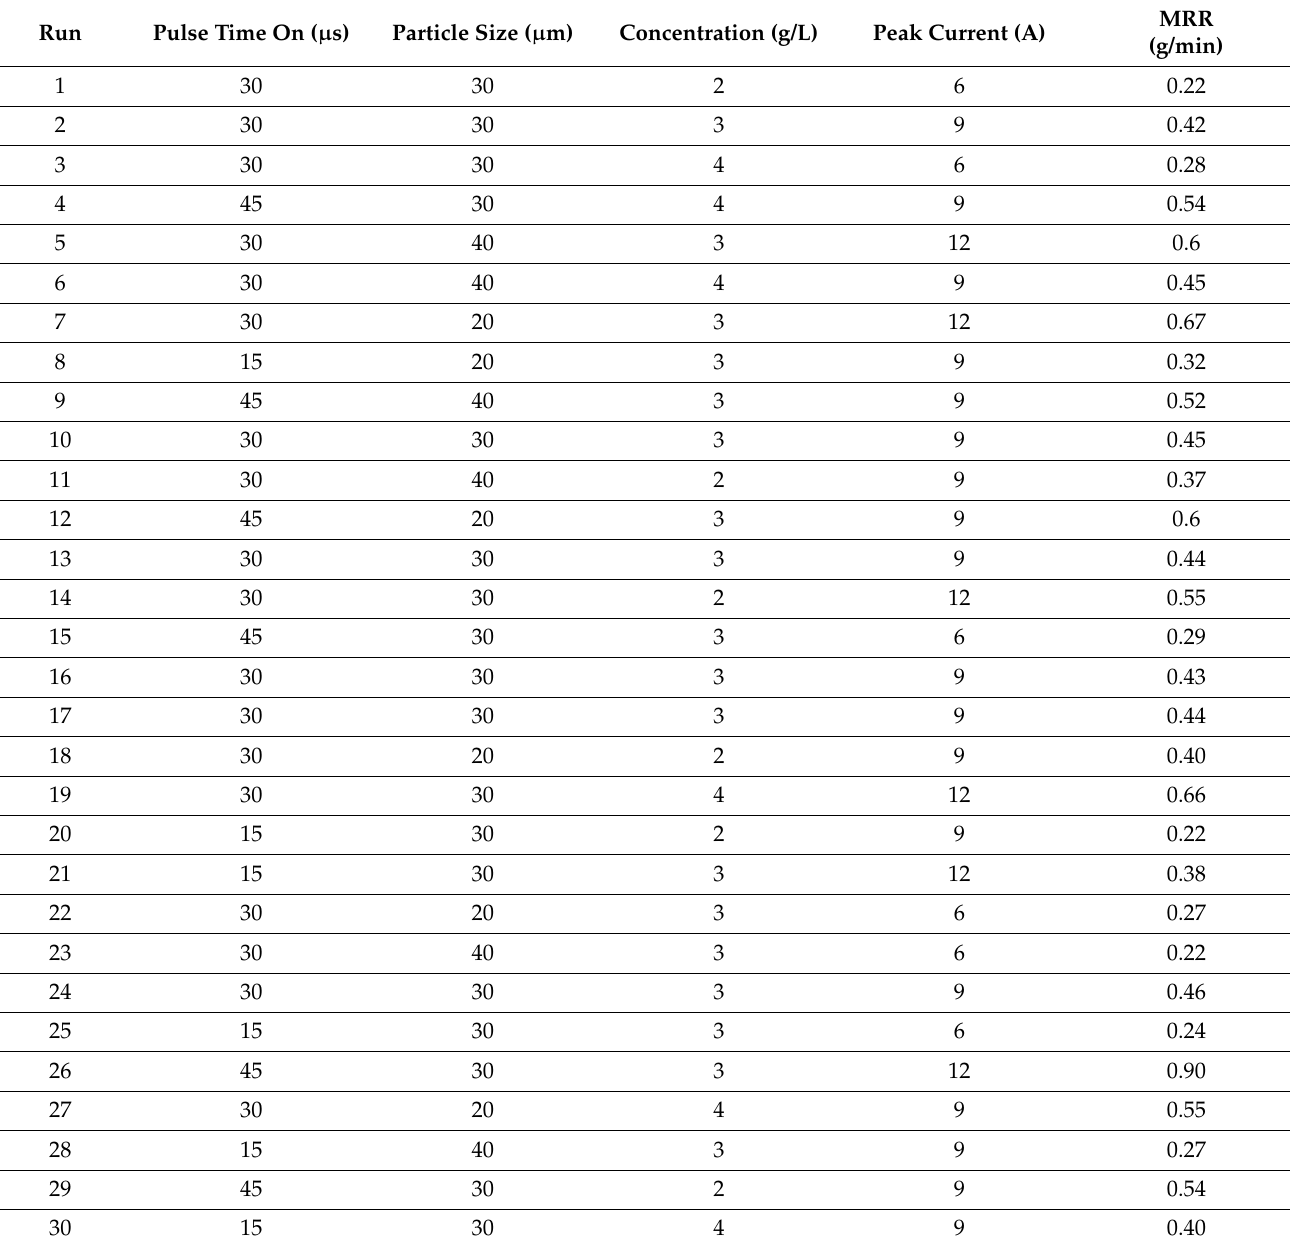
Table 6. MRR results with different